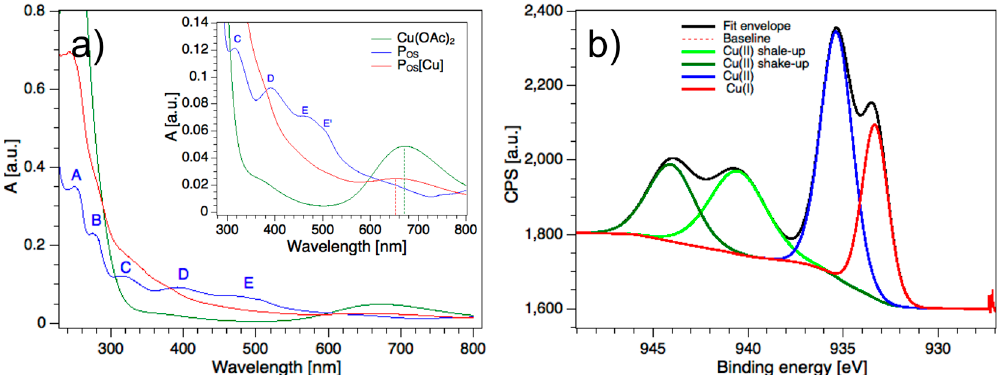
Figure 2. ( a ) UV/Vis absorption spectra of the polymer P OS and its coordination compound P OS [Cu] (inset) in acetonitrile; ( b ) binding energies of the Cu 2p core levels analyzed by